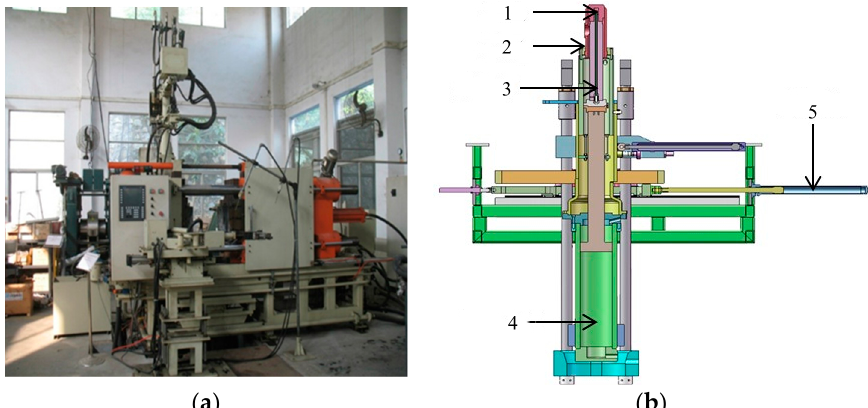
Figure 2. Squeeze casting machine ( a ) picture and ( b ) structure. Note: 1—punch; 2—shot sleeve; 3—pushing rod; 4— pushing cylinder; 5—horizontal displacement cylinder.